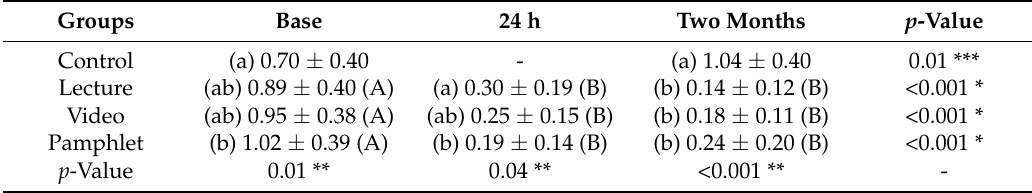
Table 2. Comparison of PI in interaction groups at different